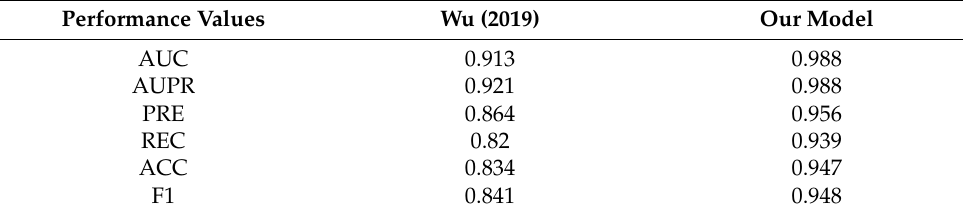
Table 4. Performance of our model compared with Wu’s